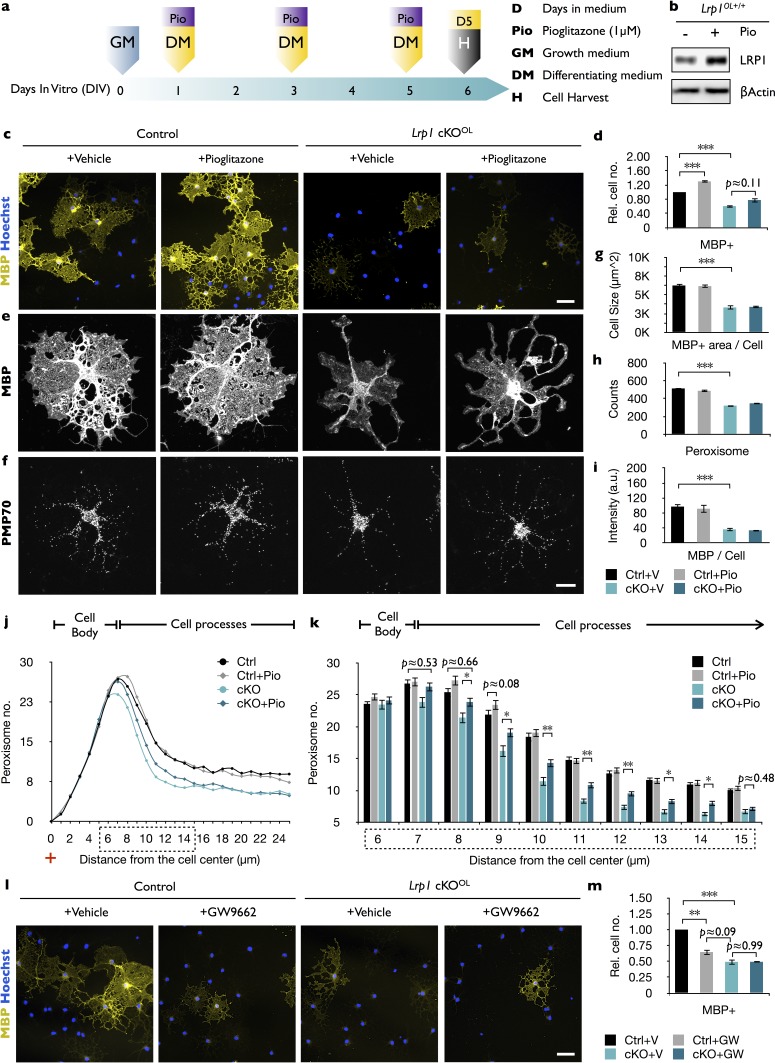
In Lrp1-deficient OPCs, PPARγ activation increases peroxisome density but does not promote cell differentiation.(a) Timeline in days showing when growth medium (GM) or differentiation medium (DM) with pioglitazone (Pio) were supplied and cells were harvested for analysis. (b) Immunoblots of OL lysates prepared from Lrp1 wildtype cultures after 5 days in DM with (+) or without (-) Pio, probed with anti-LRP1β. Anti-β-actin is shown as loading control. (c) Immunostaining of Lrp1 control and cKOOL cultures after 5 days in DM. Representative cell cultures stained with anti-MBP and Hoechst dye 33342. Scale bar = 50 µm. (d) Quantification of MBP+ cells in Lrp1 control cultures with vehicle (n = 6), Lrp1 control cultures with Pio (n = 6), cKOOL cultures with vehicle (n = 4), and cKOOL cultures with Pio (n = 4). (e–f) Primary OLs probed with anti-MBP and anti-PMP70. Scale bar = 10 µm. (g–i) Quantification of OL size in µm2 (g), the number of PMP70+ puncta (h), and the intensity of MBP staining per cell (i). (j) Distribution of peroxisomes as a function of distance from the cell center in Lrp1 control and cKOOL OLs treated ±Pio. The number of PMP70+ peroxisomes between 6–15 µm in Lrp1 control and cKOOL cultures was subjected to statistical analysis in (k). Lrp1 control (n = 112 cells, three mice), Lrp1 control cultures with Pio (n = 180 cells, three mice), cKOOL (n = 60 cells, three mice), and cKOOL cultures with Pio. (n = 110 cells, three mice) (k). (l) Immunostaining of OLs after 5 days in DM ±GW9662, probed with anti-MBP and Hoechst dye33342. Scale bar = 50 µm. (m) Quantification of MBP+ cells under each of the four different conditions (n = 3 per condition). Results are shown as mean values ± SEM, *p<0.05, **p<0.01, and ***p<0.001, 2-way ANOVA, post hoc t-test. For a detailed statistical report, see Figure 6—source data 1.10.7554/eLife.30498.020Figure 6—source data 1.Raw data and detail statistical analysis report.